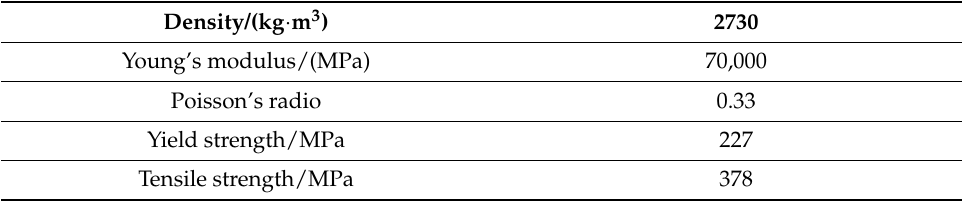
Table 2. 5052 aluminum alloy material properties.